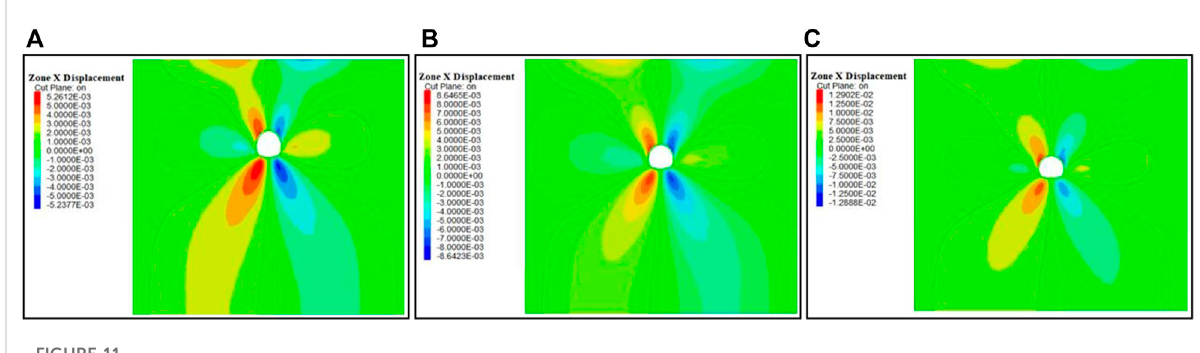
FIGURE 11 Horizontal displacement cloud map of different depths. (A) Horizontal displacement cloud map of 30 m buried depth; (B) horizontal displacement cloud map of 40 m buried depth; and (C) horizontal displacement cloud map of 50 m buried